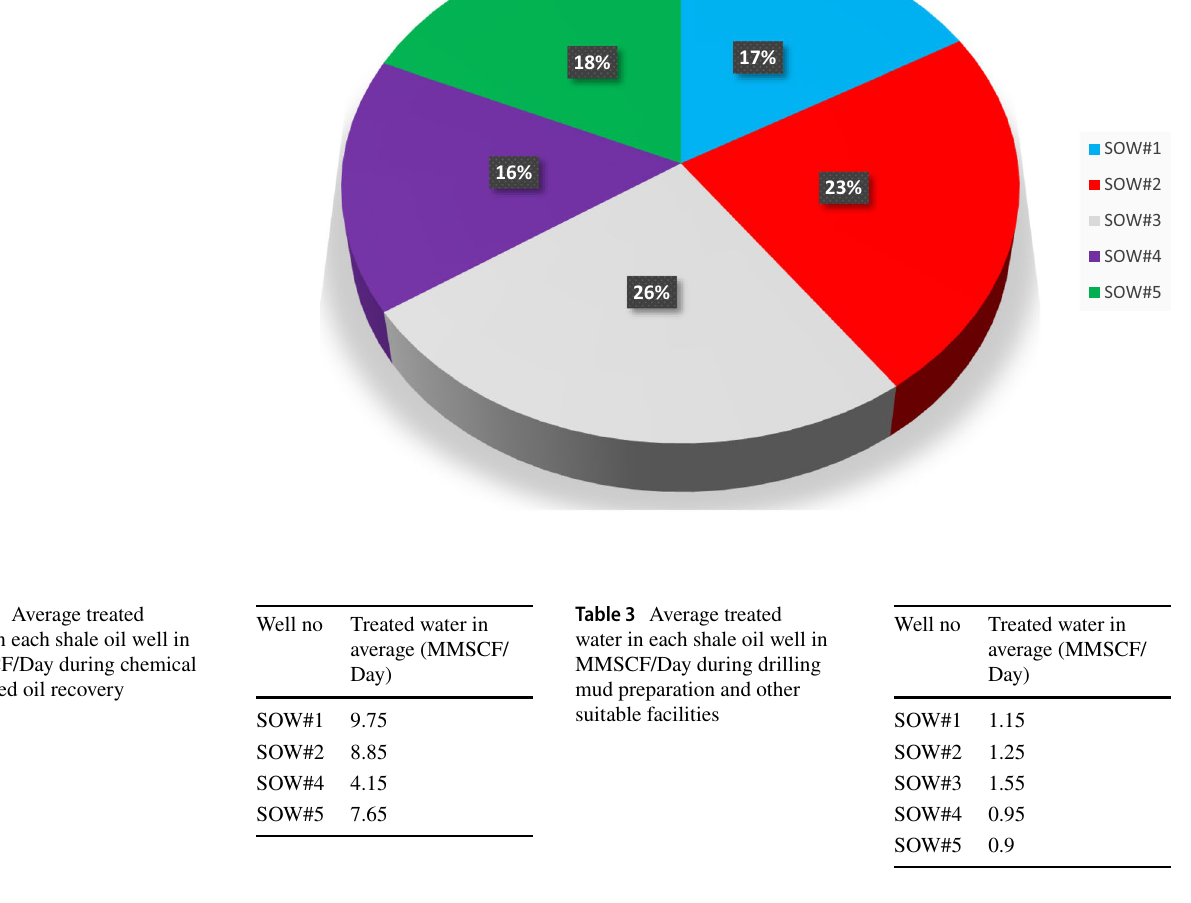
Fig. 1 Treated wastewater for each shale oil well during hydraulic fracturing